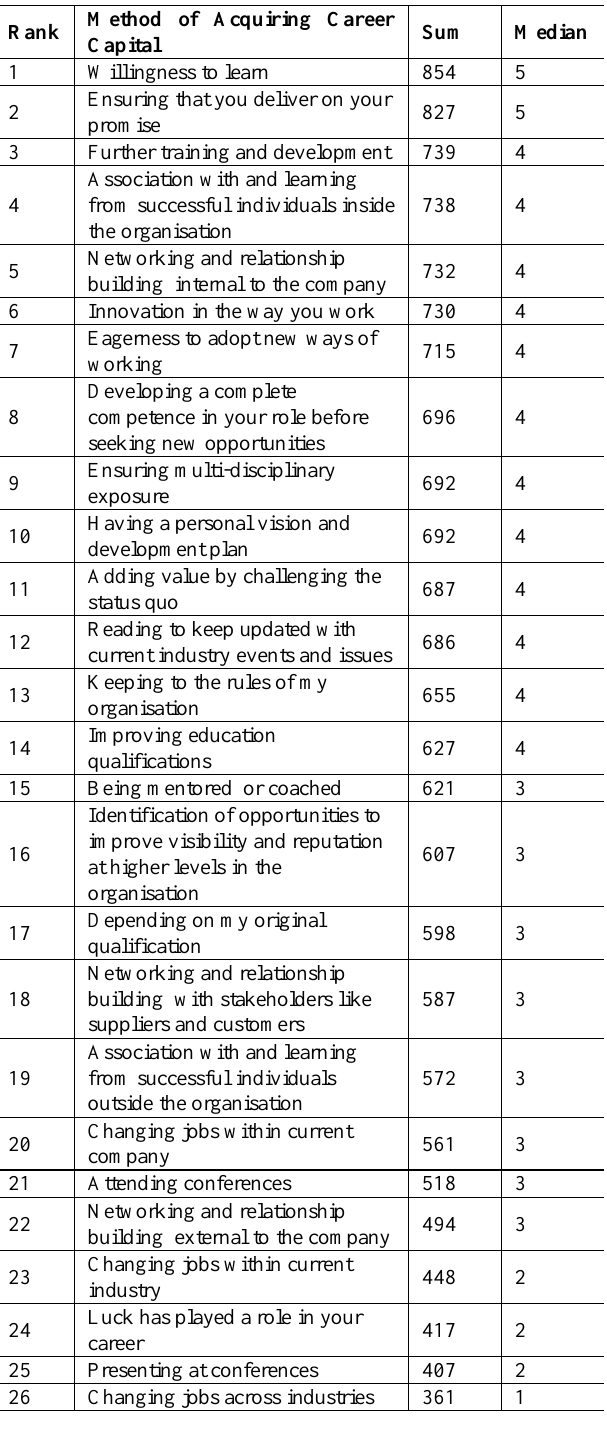
Table 3: Ranking of usage of methods for the accrual